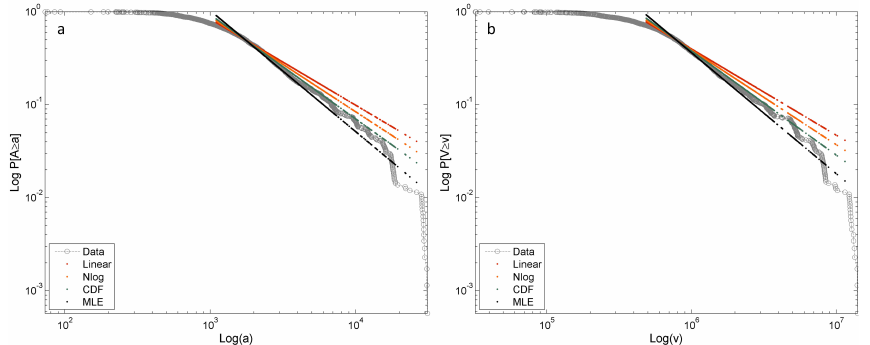
Fig. 3. (a) Probability of drainage area and (b) Probability of volume drainage computed for TR = 3m and D 50 = 960µm with a grid size of